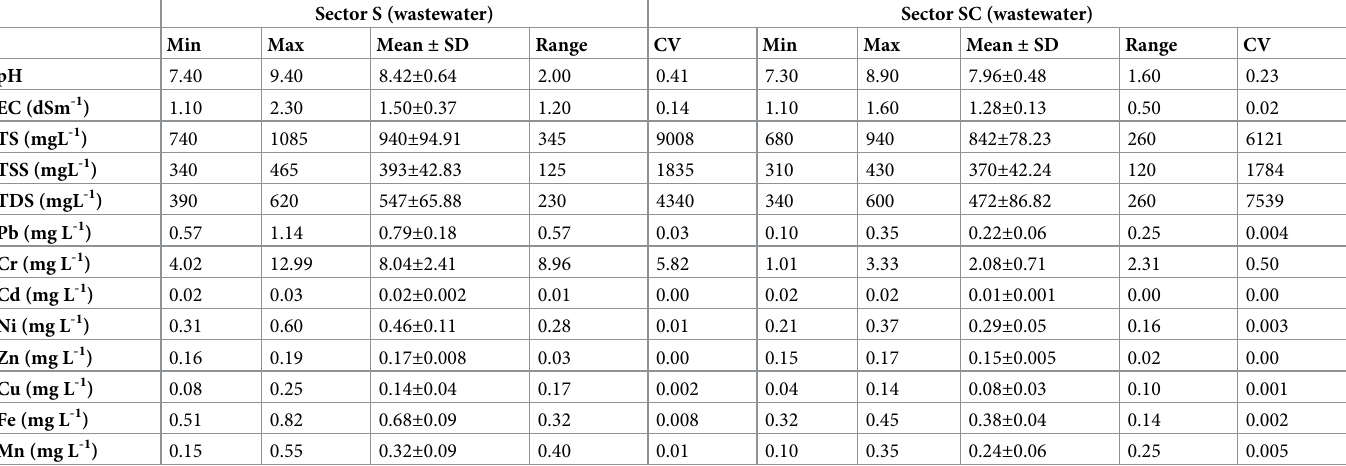
Table 2. Descriptive statistics for physicochemical properties and heavy metals concentration in water of